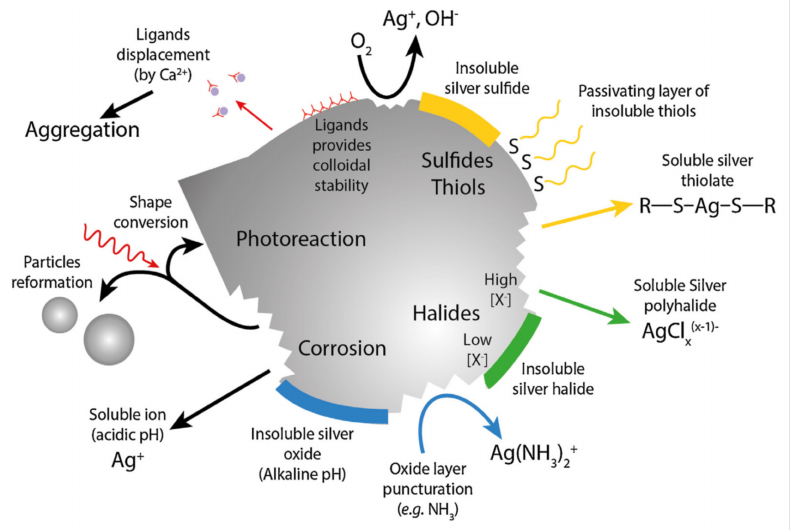
Figure 14. Summary of the factors affecting Ag NP dissolution and inhibition of growth of bacteria (adapted with permission from reference